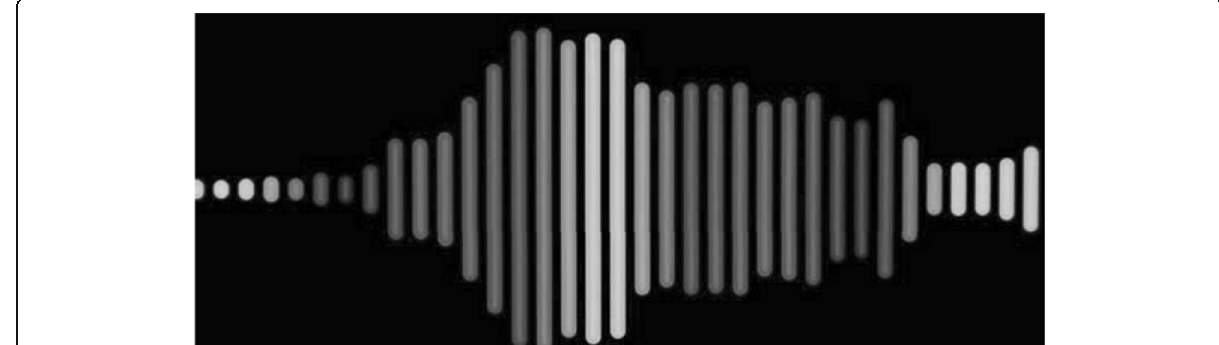
Fig. 9 The a sound image of small group that Horne uses [o] vowel